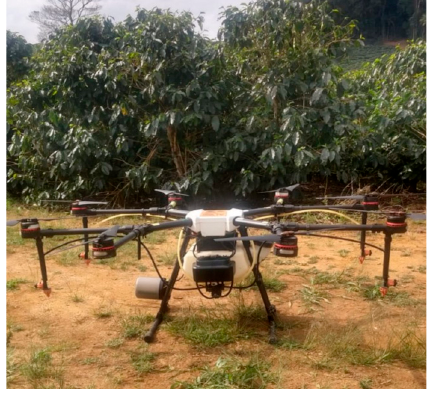
Figure 1. Multirotor unmanned aerial vehicle used for spraying in the experiment.